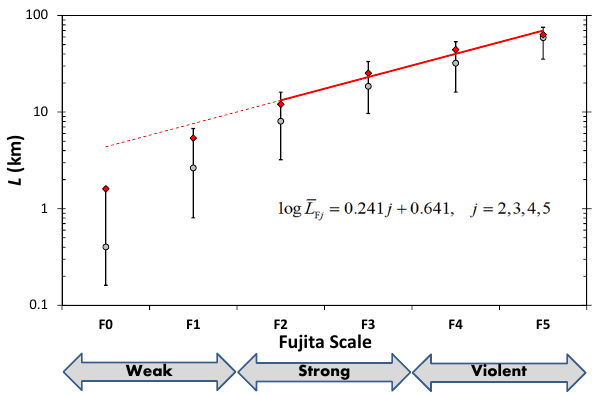
Fig. 3. Continental USA tornado touchdown path length statistics as a function of Fujita (or Enhanced Fujita) scale intensity F0, F1, ..., F5, for the time period 1982–2011, with all path lengths L con- sidered. Included are the mean path lengths L F j (red diamonds) for each Fujita scale intensity (F j , j = 0, 1, 2,..., 5), median values (grey circles), and the 75th and 25th percentile (upper and lower horizontal lines). Also given (thick red line) is the best-fit to the mean values for strong (F2, F3) and violent (F4, F5) tornadoes (Eq. 1). Tornado path length and Fujita scale intensity data are from NOAA